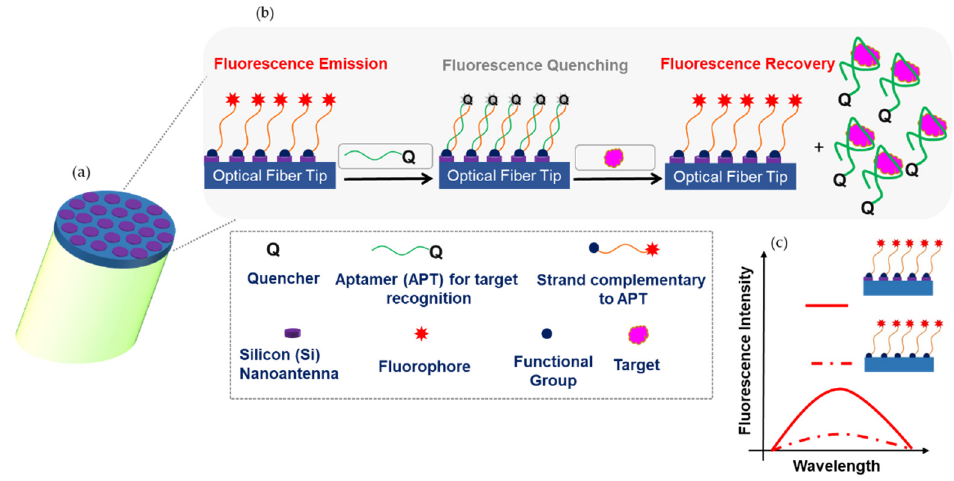
Figure 10. ( a ) Probe’s nanoantenna schematic. ( b ) Proposed detection technique based on the probe’s nanoantenna functionalization with a strand labeled with a fluorophore capable to hybridize with a complementary aptamer bearing a quencher. When the fluorophore and the quencher are in close proximity, fluorescence quenching occurs. Fluorescence is recovered in the presence of the target. ( c ) Illustration of the fluorescence intensity enhancement.